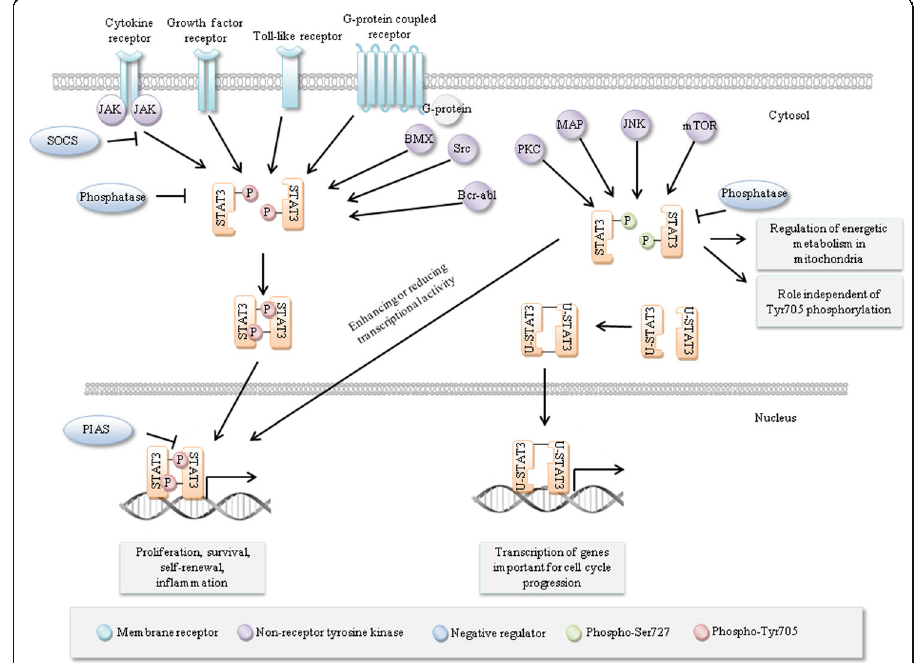
Fig. 3 STAT3 regulation. Multiple signals lead to phosphorylation of STAT3 at Tyr705 or Ser727, leading to dimerization, nuclear import and transcriptional activation. SOCS proteins, phosphatases and PIAS proteins inhibit STAT3 activity at different stages of STAT3 activation. Other modifications including ubiquitination, acetylation and methylation may also